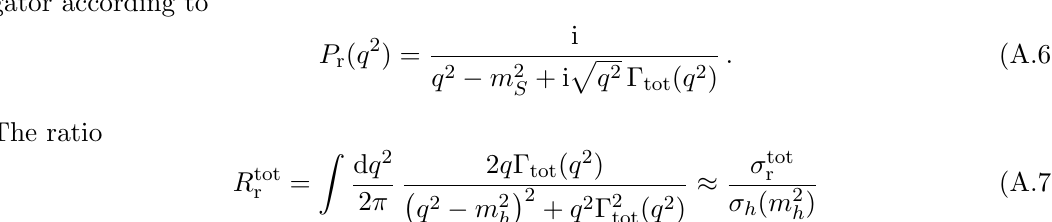
Figure 7 . Cross section ratios R f (cid:25) (cid:27) f (cid:12)xed- and a running-width prescription for the Higgs-boson propagator, respectively. We consider the ratios R tot w.r.t. the total cross section (black), R vis w.r.t. the SM Higgs-decay products (red) and R inv w.r.t. the Higgs decay into singlets (blue). This plot is obtained for (cid:21) HP =